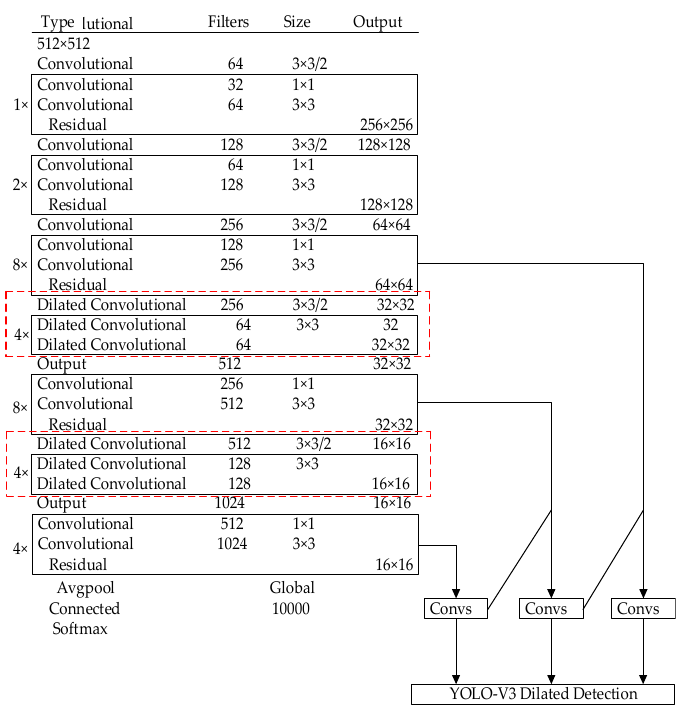
Figure 4. YOLOv3 network structure based on dilated convolution.